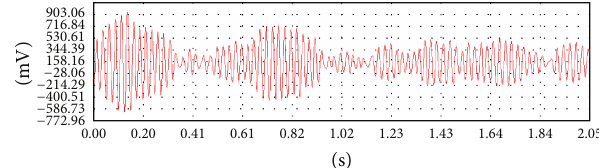
Figure 14: Frequency domain of the wingtip’s dynamic response of a controlled SMA composite wing when the mean wind velocity 𝑉 = 6 m/s.